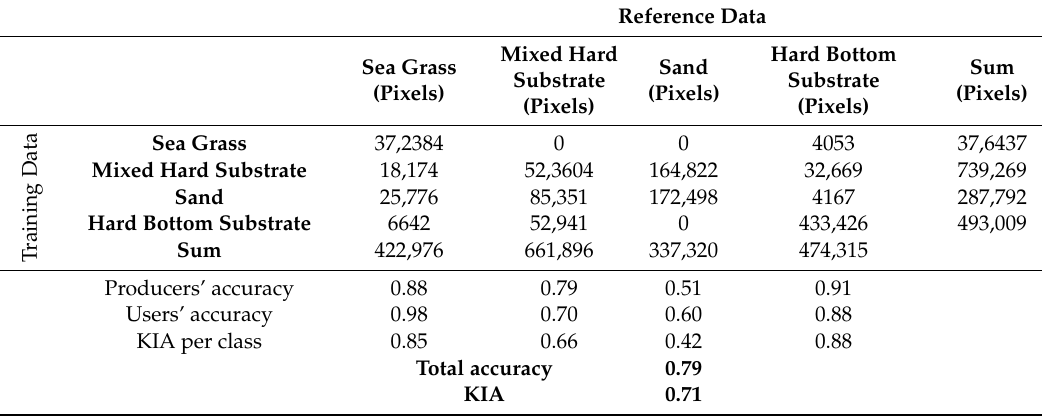
Figure 7. Point vector dataset containing: (i) 33 points (round shape) derived from in situ divers’ photos and (ii) 87 points created through photointerpretation (star shape). All points are colored according to their assigned class. Table 4. Accuracy matrix for the true-color RGB (tc-RGB) orthomosaic, with k-nearest neighbor as the classifier. KIA: Kappa index of